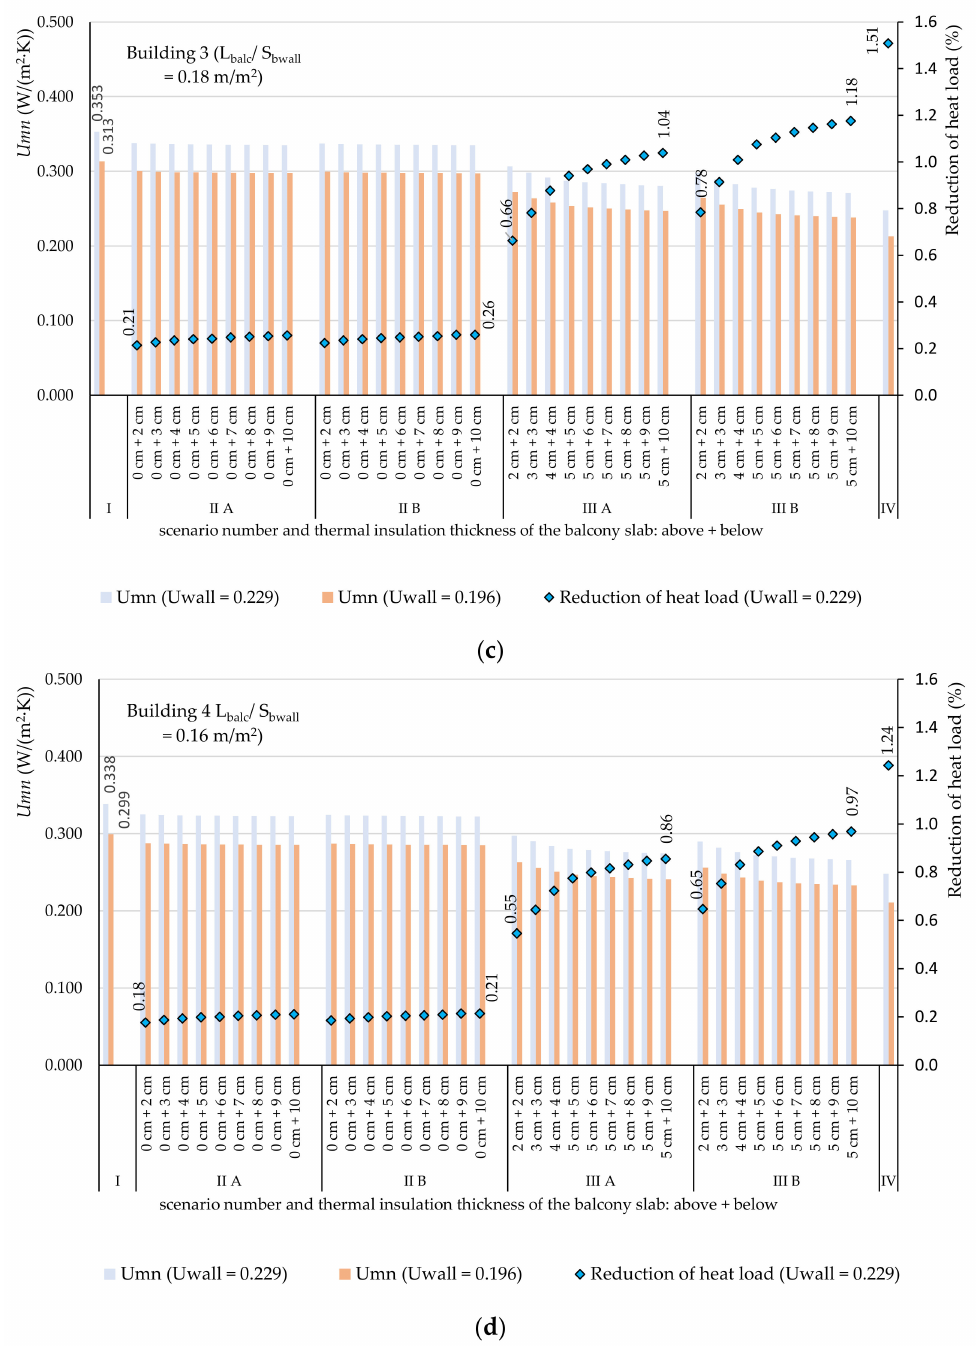
Figure 10. The influence of thermal bridges of balconies in different scenarios and reduction of the heat load of individual analyzed buildings: ( a ) building no. 1; ( b ) building no. 2; ( c ) building no. 3; ( d ) building no.